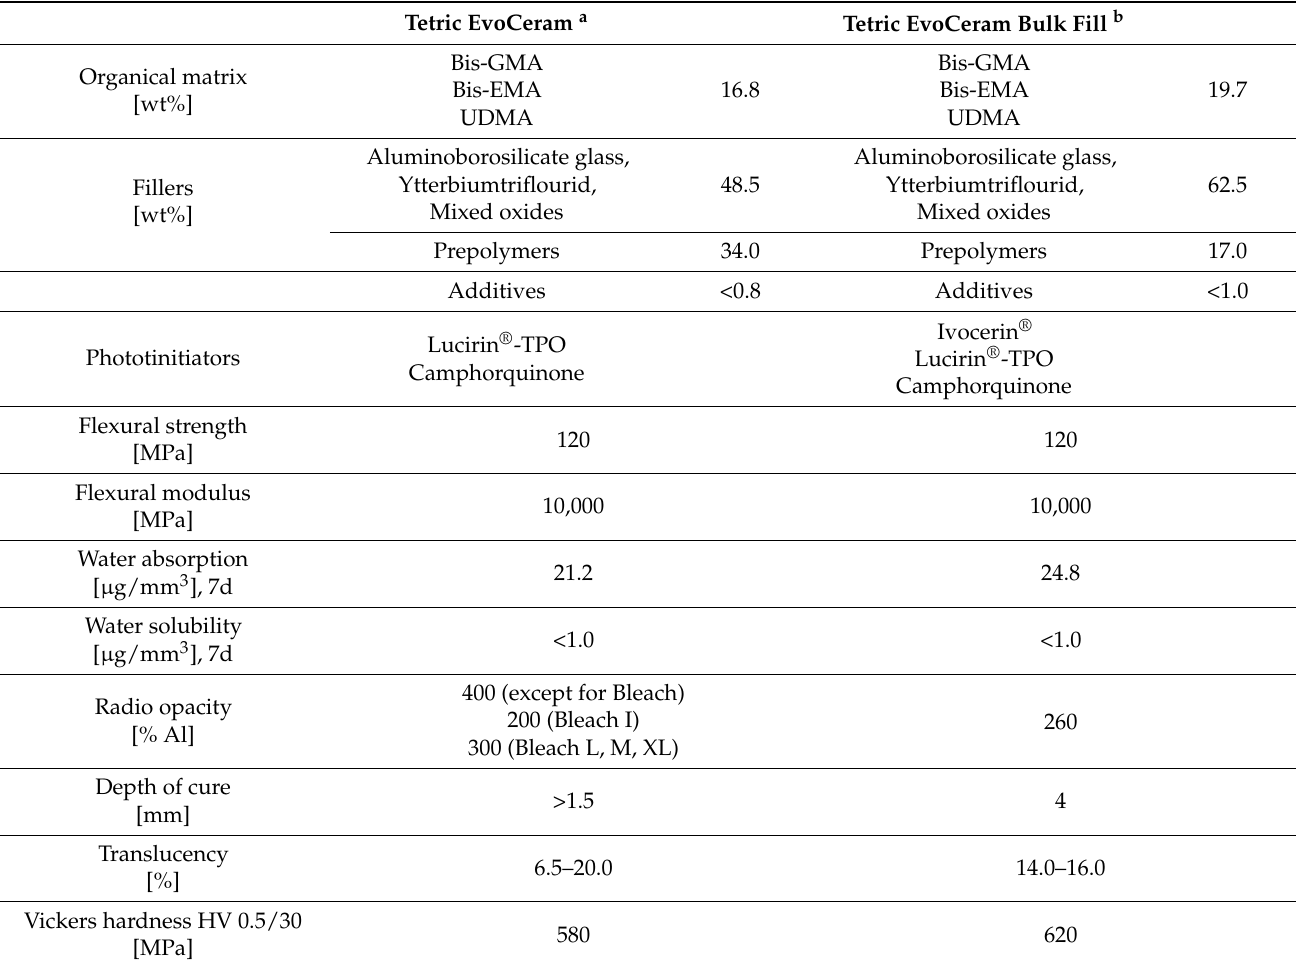
Table 1. Material compositions and physical properties. Tetric EvoCeram a Tetric EvoCeram Bulk Fill